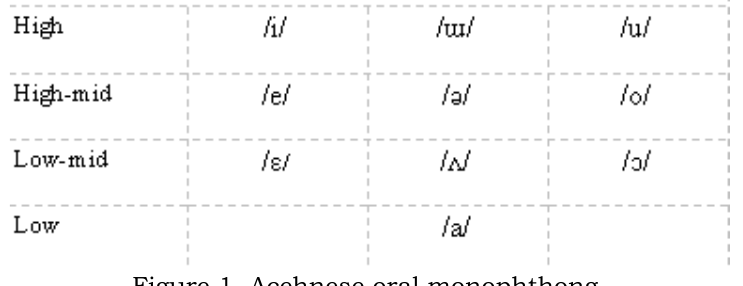
Figure 1. Acehnese oral monophthong